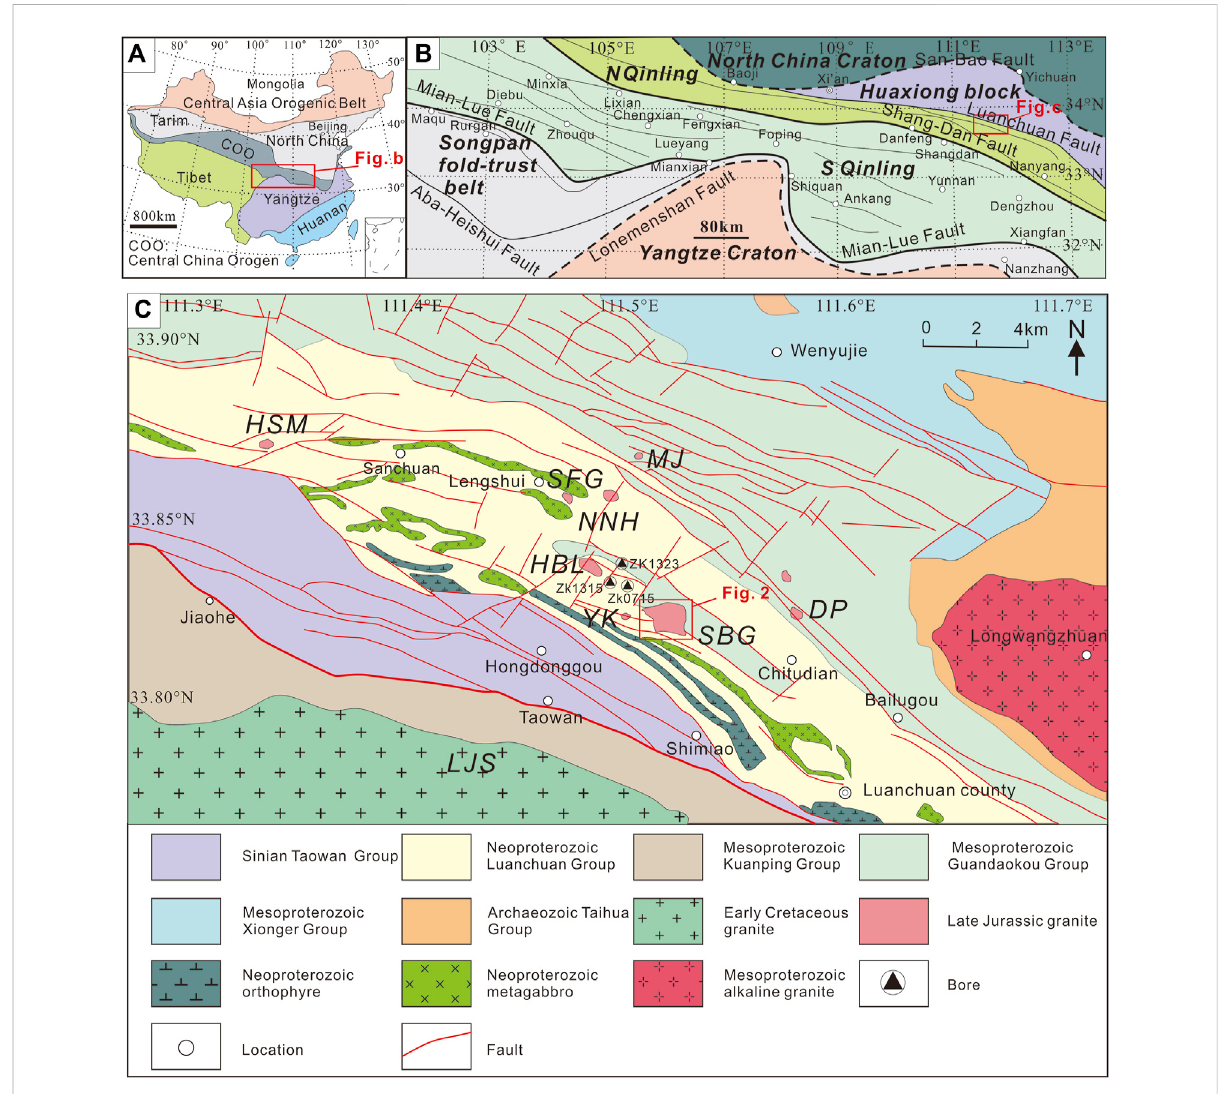
FIGURE 1 (A) Tectonic map of China showing the location of Central China belt and North China Craton; (B) tectonic subdivision of the Qinling Orogen showing the location of Luanchuan ore district; and (C) geological map of Luanchuan ore district displaying the geology and the distribution